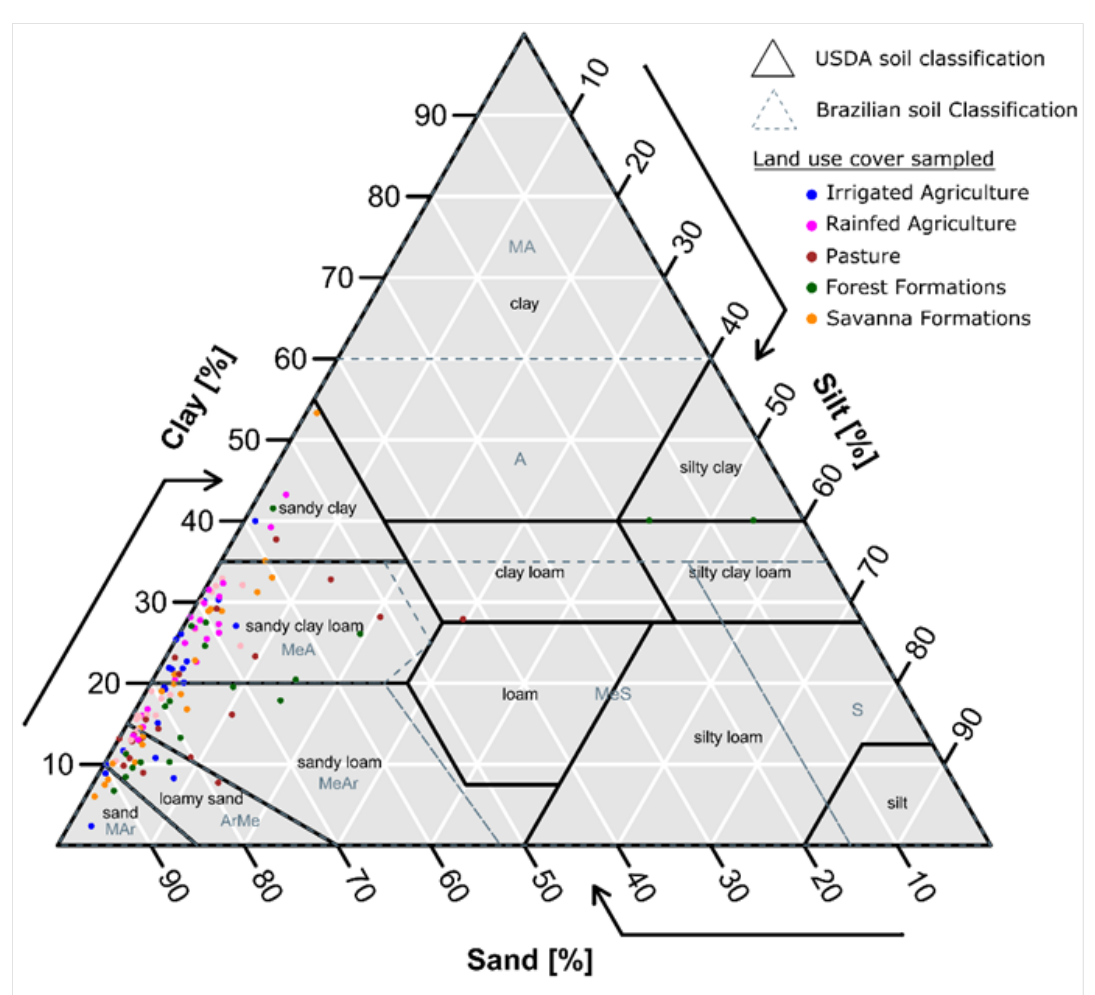
Figure 2. Average soil texture fractions for 0–5 cm layer in Western Bahia according to the USDA soil classification and to the Brazilian soil classification